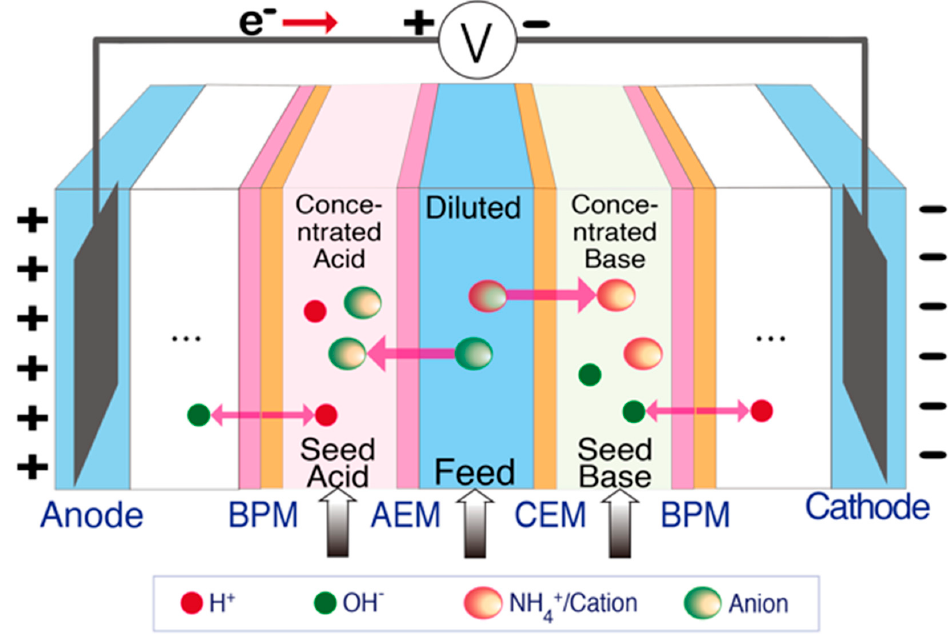
Figure 2. Schematic of BPM integrated ED for ammonia